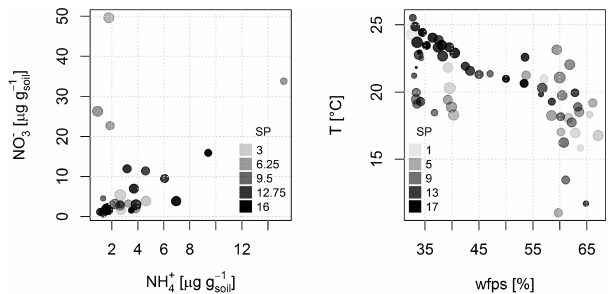
and NO − and SP in rela- 4 3